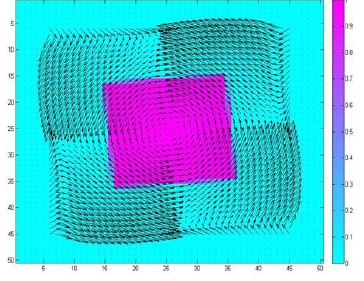
Figure 20. Results of Lucas/Kanade (Win=5, Sigma=3)